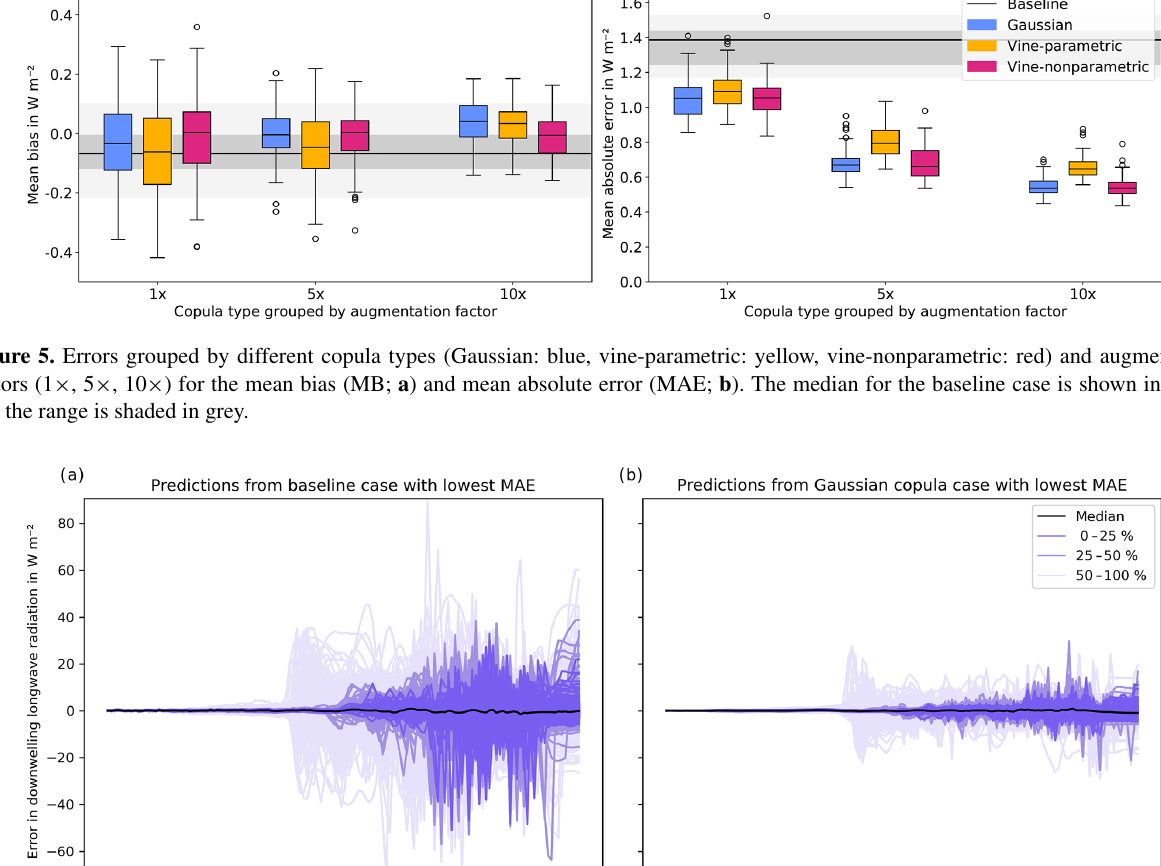
Table 2. Mean bias (MB) and mean absolute error (MAE) for base- line and copula cases. Statistics shown for the ML emulator com- bination with the lowest MAE. Baseline trained using 10000 real NWP-SAF profiles. Copula cases were trained using 110000 pro- files (10000 real and 100000 synthetic), i.e. with an augmentation factor of 10 × . Bold indicates the lowest error. Case MB (Wm − 2 ) MAE (Wm − 2 ) Baseline 0.08 1.17 Gaussian − 0.02 0.45 Vine-parametric 0.10 0.56 Vine-nonparametric − 0.05 0.44